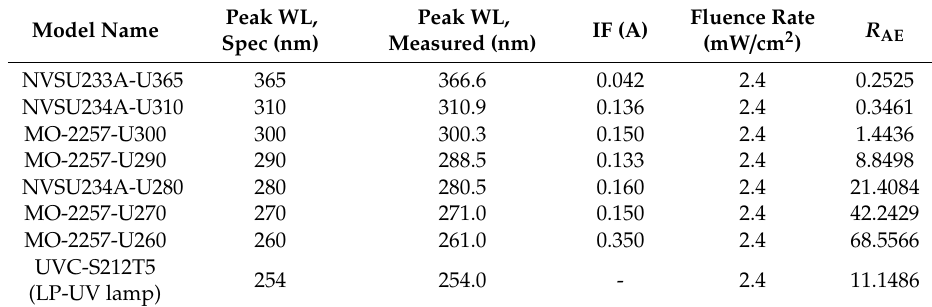
Table 1. Characteristics and Irradiating Conditions of the UV-light emitting diodes (UV-LEDs) and Low Pressure (LP)-UV Lamp Used in This Study.